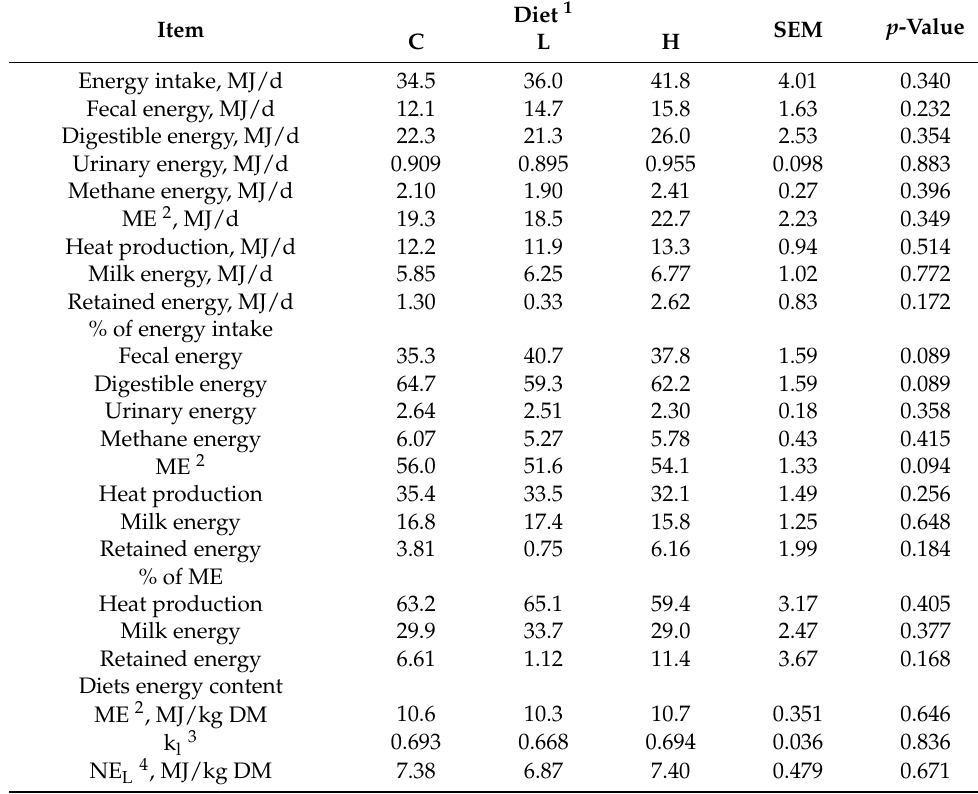
Table 9. Energy balance of the goats fed the experimental